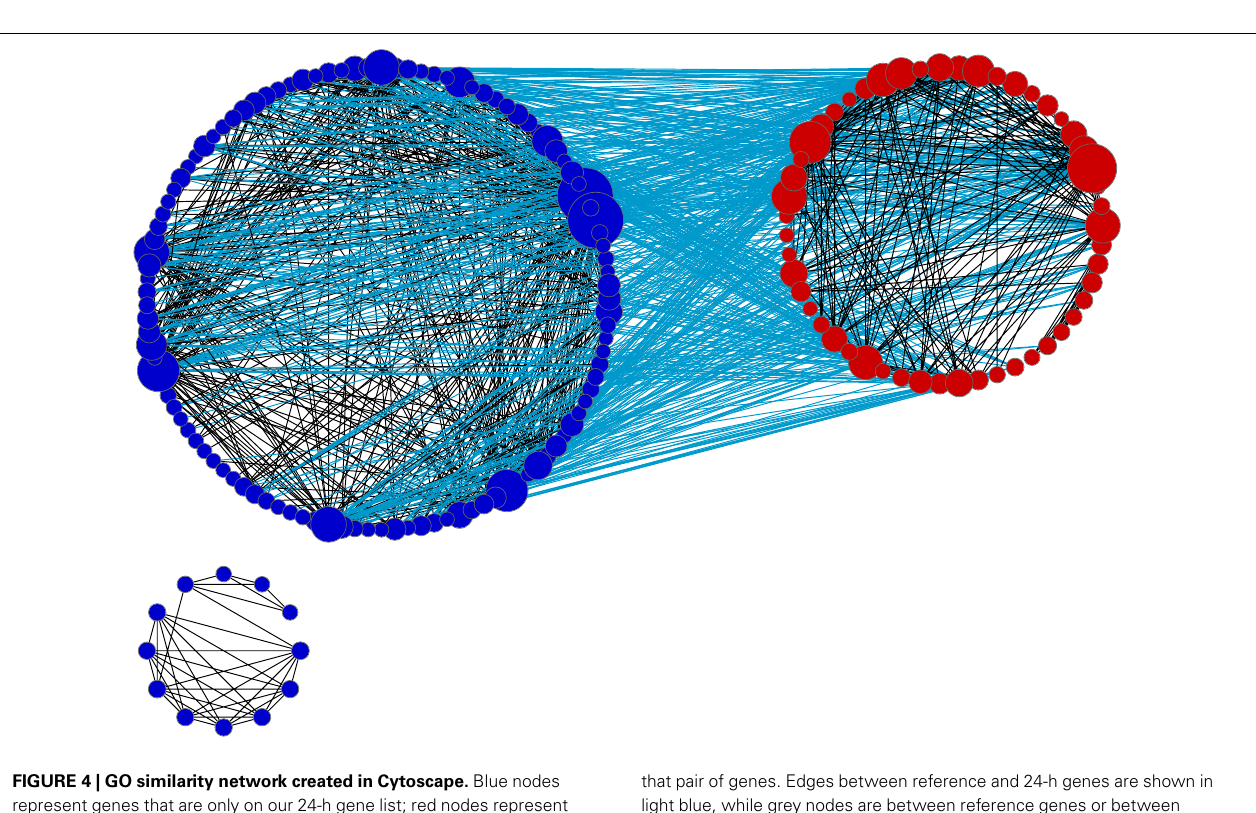
FIGURE 4 | GO similarity network created in Cytoscape. Blue nodes represent genes that are only on our 24-h gene list; red nodes represent reference genes. The two types of nodes were grouped separately so that the interactions between two groups are easily visible. An edge between two nodes signifi es that there are at least 60 GO terms that are common for